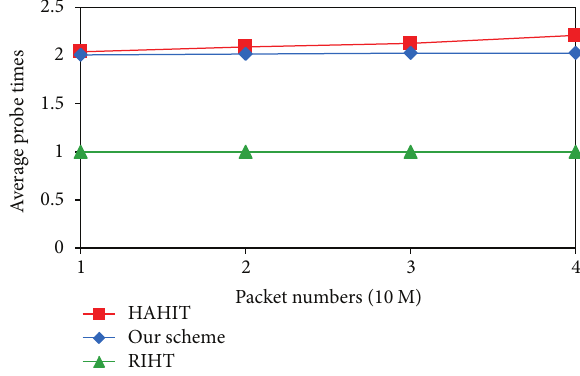
Figure 9: Average probe times in path